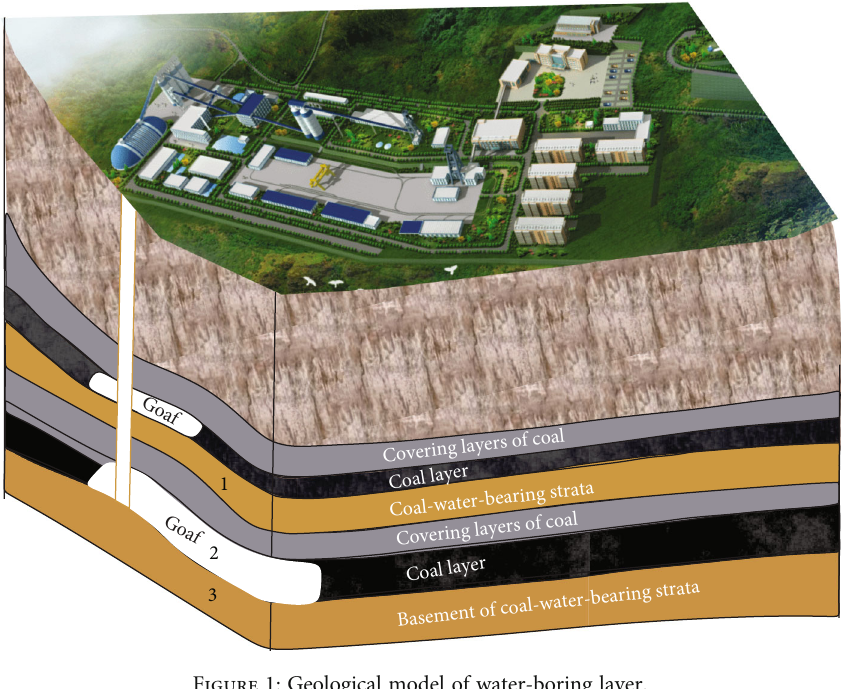
Figure 1: Geological model of water-boring layer.